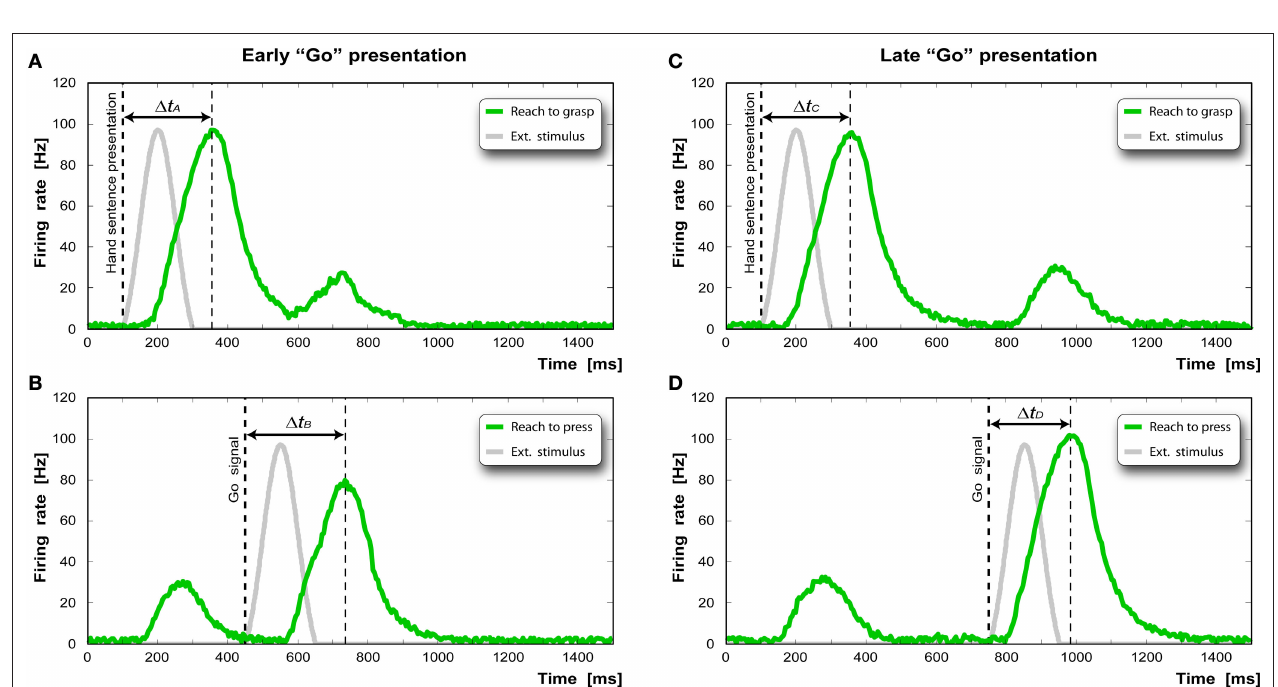
Figure 4 | effect of the parameters α and β on the shape of the firing rate adaptation current. (A) A decrease of β (from 3.0 to 1.9 nA/s) produces a slower deactivation of I , thus shifting the inhibitory phase further in time. fra